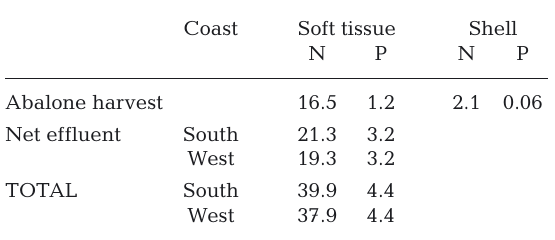
Table 4. Farm N and P outputs normalised to production (kg N or P mt −1 ) as calculated for harvested soft tissue/shell and as measured in effluents. Soft tissue moisture (77.9%) and protein (62.3%) for Haliotis midae is from Britz & Hecht (1997). Shell moisture (16.51%) and protein (6.31%) were calculated from Knauer et al. (1994) assuming soft tissue is 75% of whole weight (M. Naylor pers. comm.). The P soft tis- sue (0.70%) and shell (0.022%) content was as calculated from data in Tan et al. (2001) for H. discus